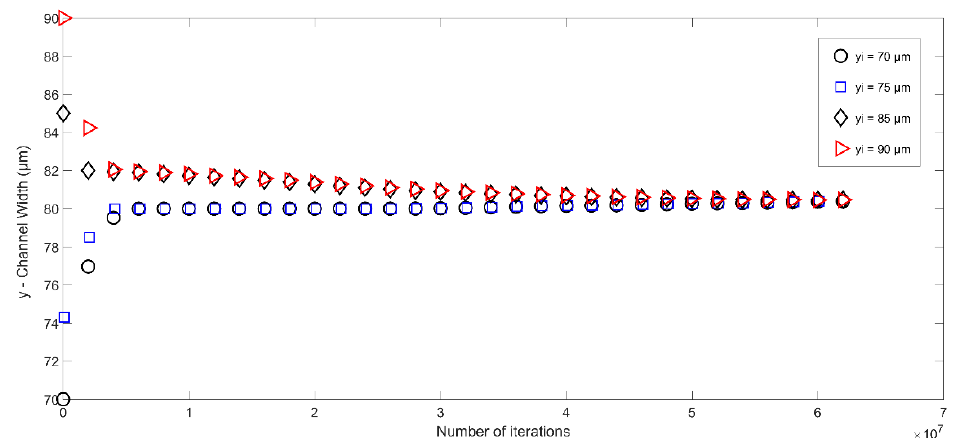
Figure 7. Trajectory of microparticles subjected to acoustic radiation force in microchannel as a function of time and initial position (pressure node is at the center of the microchannel).